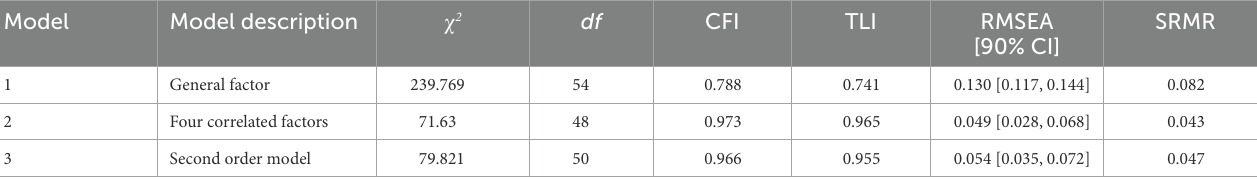
TABLE 2 Model fit indices of the three alternative/competing models in Figure 1.